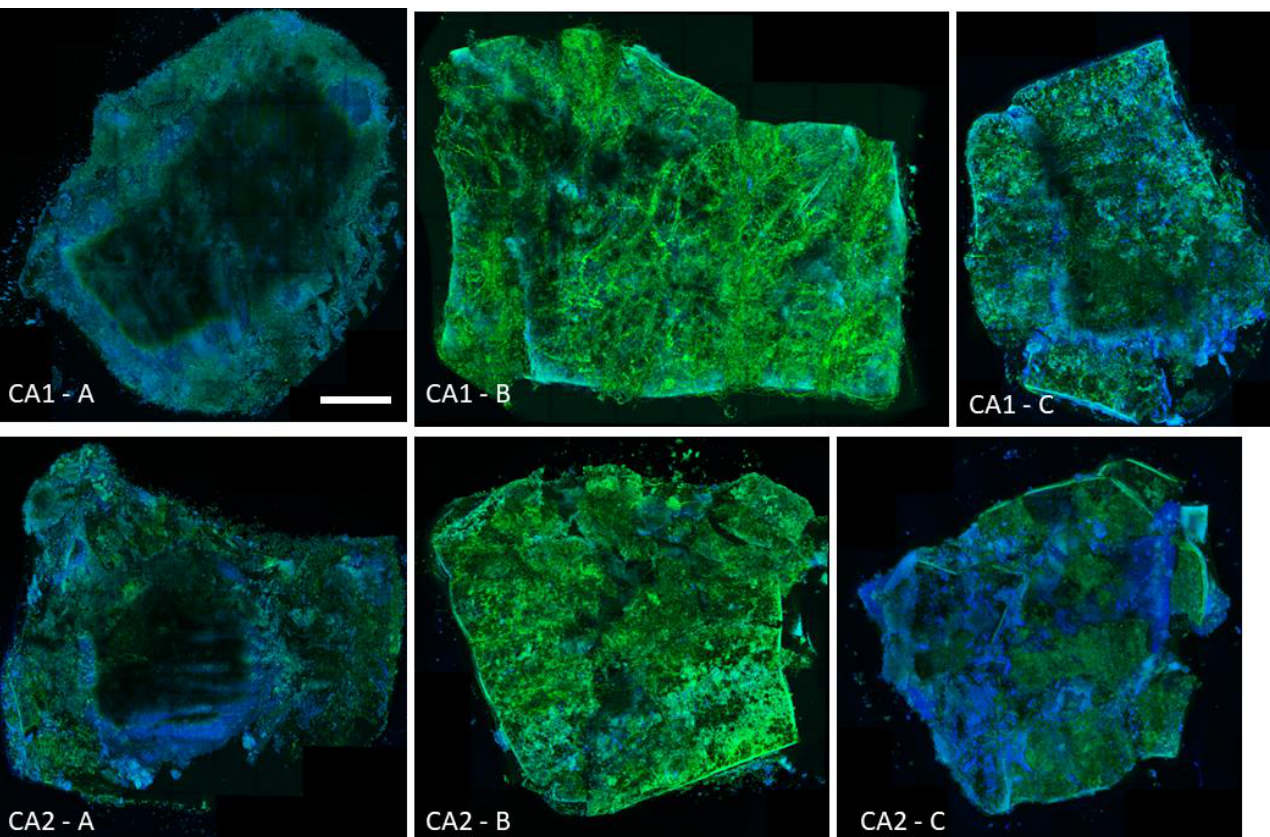
Figure 1. Mature 24-h biofilm of Candida albicans strains CA1 and CA2 isolated from VVC on mouse vaginal epithelium tissue (ex vivo model) under the confocal microscopy. Green color shows C. albicans based on Calcofluor staining and blue labels the vaginal epithelium based on Evans blue dye. CA 1 – A and CA 2 – A — negative controls (tissue without Candida ); CA 1 – B and CA 2 – B — biofilm of strain number 1 and strain number 2, respectively; CA 1 – C and CA 2 – C — biofilms treated with amphotericin B (50 µg/mL). Scale bar = 1 mm.